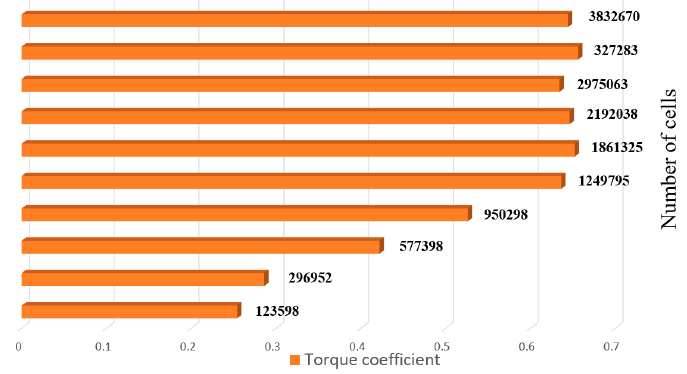
Figure 4. Average torque coefficient vs. number of cells for grid sensitivity test.